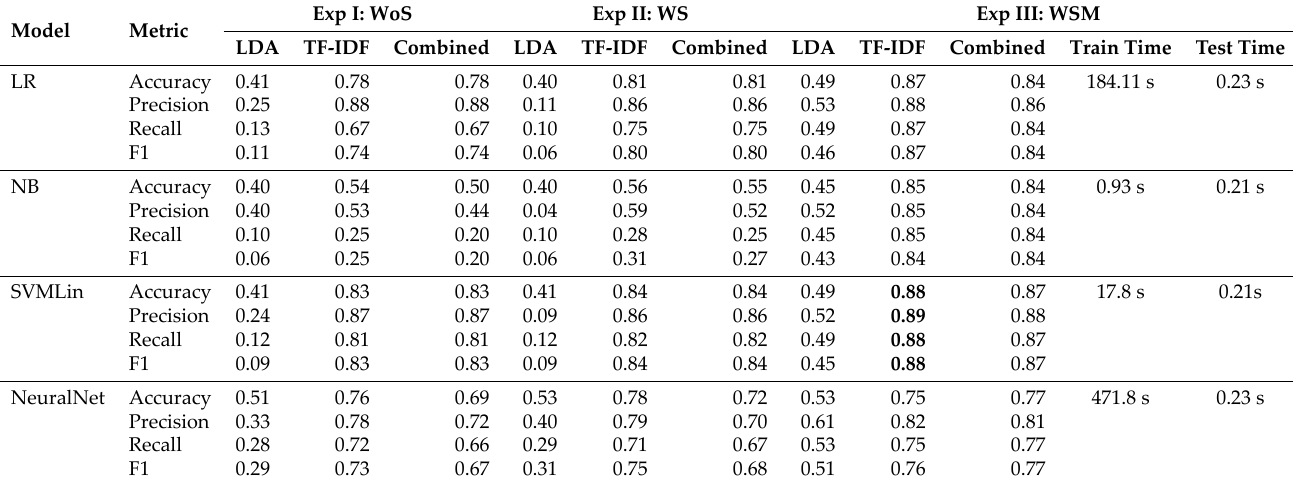
Table 5. Comparison of Performance of Supervised Topic Classifier using TF-IDF word, with (no) Stemming and with (no) SMOTE relying onAmharic text datasets. WoS = TF-IDF Word uni-gram + NoStem, WS = TF-IDF word uni-gram + Stemming, and WSM = TF-IDF word uni-gram + SMOTE, Exp = Experiment. The values in bold shows the highest performance scores of the topic classifier.